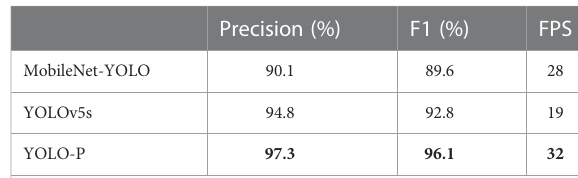
TABLE 5 Result of Akidzuki pear detection